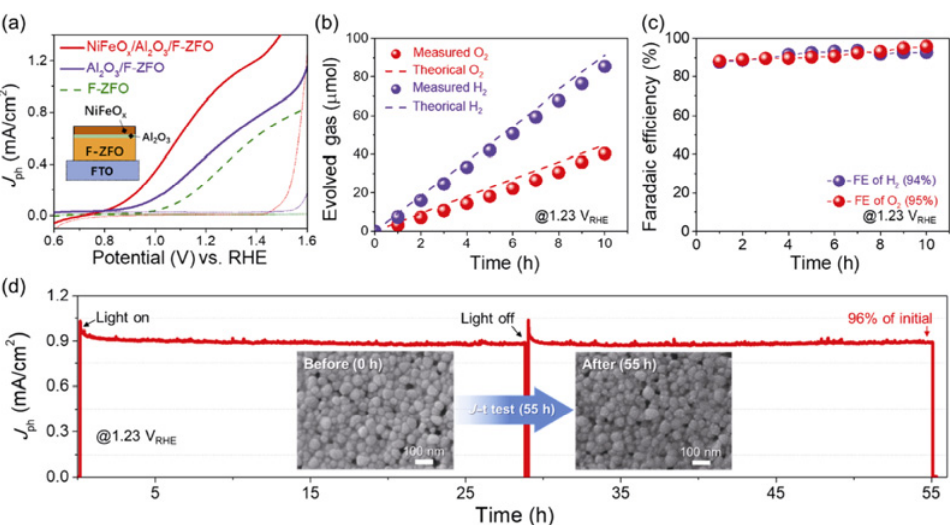
Fig. 5 Further improvement of PEC performance via depositing Al 2 O 3 and NiFeO x layers. (a) J – V curves of F-ZFO, Al 2 O 3 /F-ZFO, and NiFeO x /Al 2 O 3 /F-ZFO photoanodes. (b) Gas production measurements. A stoichiometric mole ratio of H 2 and O 2 (H 2 /O 2 = 2) was observed. (c) Faradaic efficiency (FE) measurement. (d) Long-term photocurrent stability test of the NiFeO x /Al 2 O 3 /F-ZFO photoanodes. The inset images show SEM images before and after the 55 h stability